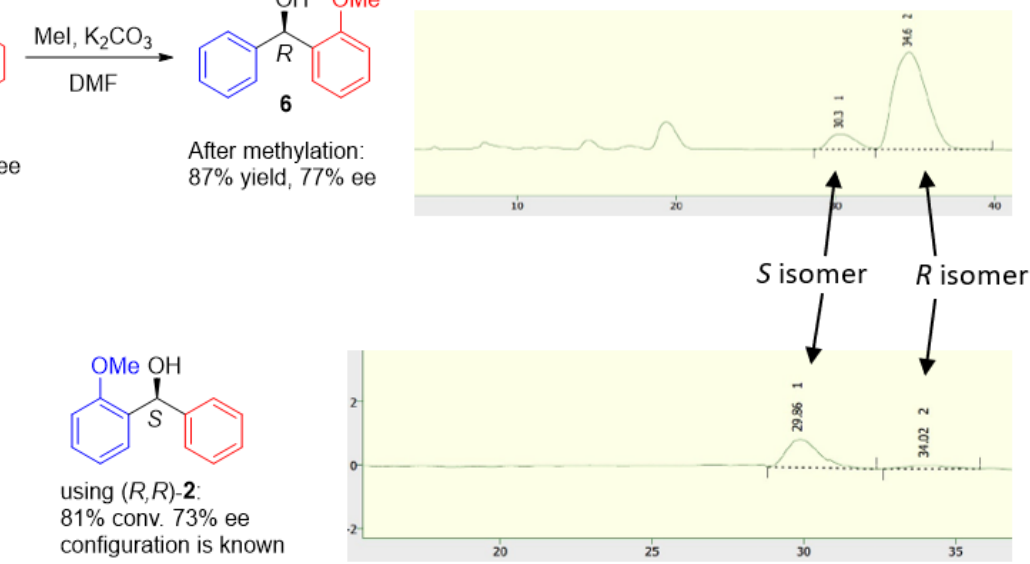
Figure 9. Determination of product configuration in ATH of ortho -hydroxy benzophenones.